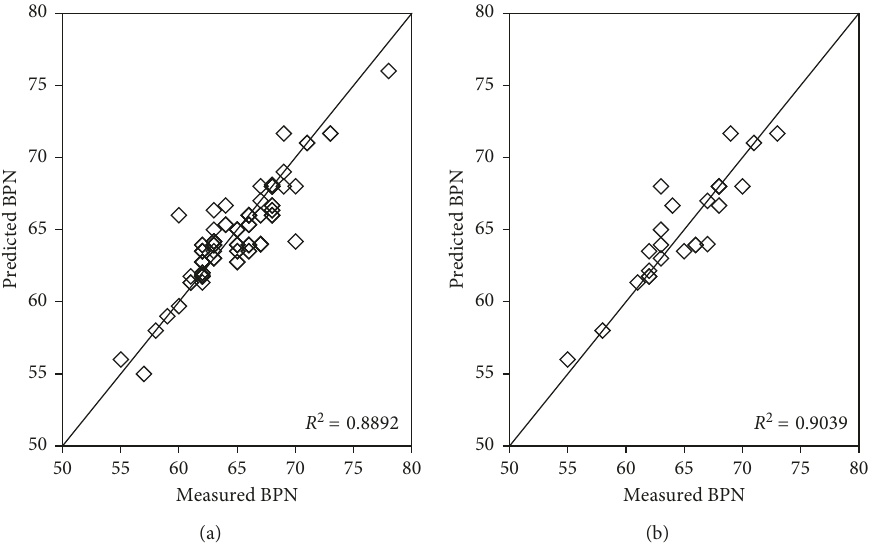
Figure 5: Comparison of the measured BPN values with the predicted BPN values from the ANN-2 model for (a) training and (b) testing samples under polishing